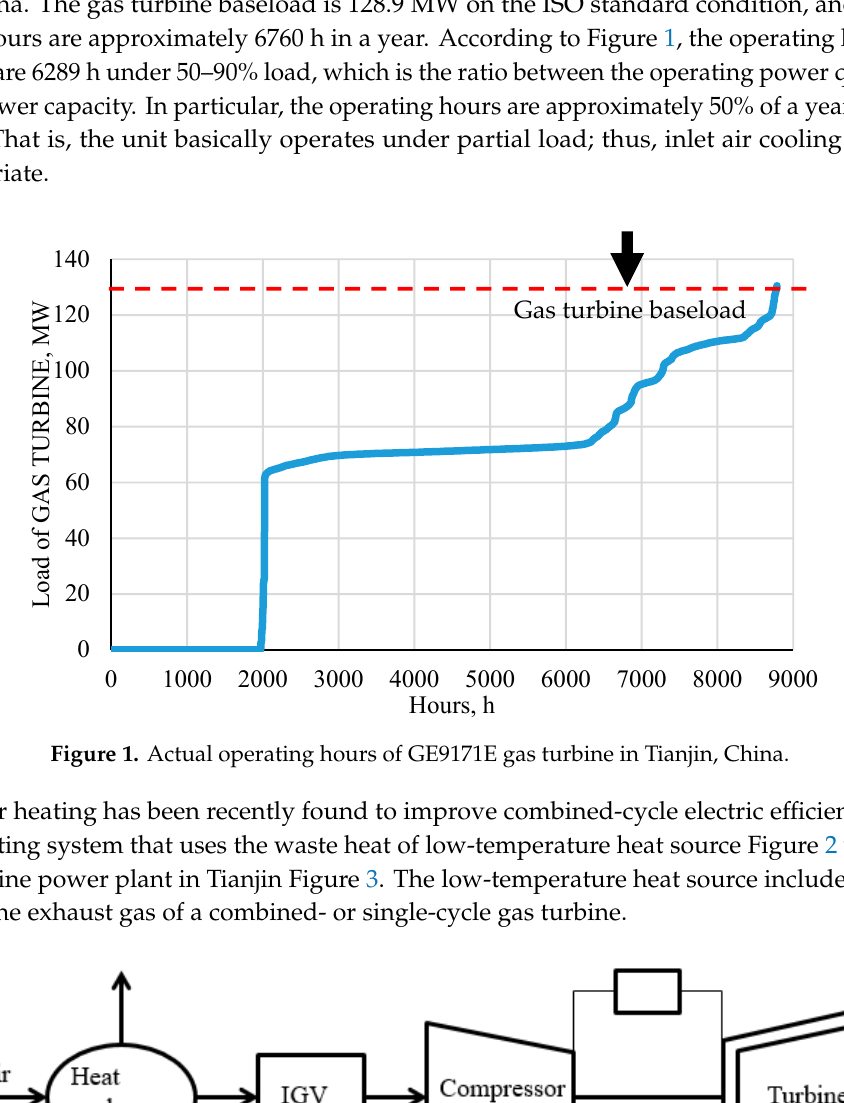
Figure 2. Diagram of an inlet air heating system of a gas turbine.